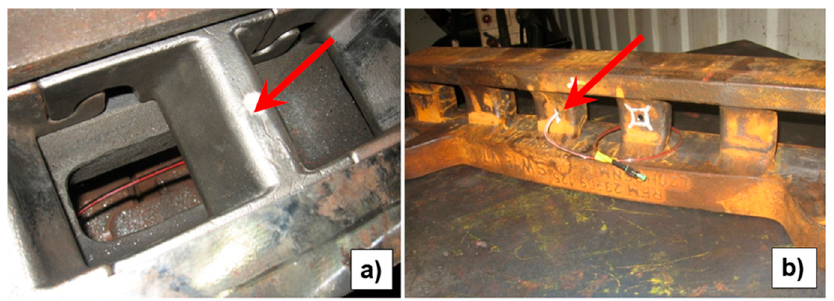
Figure 6. View of one of the toothed bar segments of the Flextrack system ( a ) and of the rack of the Eicotrack system ( b ), with a glued-in optoelectronic sensor with Bragg net for measurements of strains, (marked with red arrows).